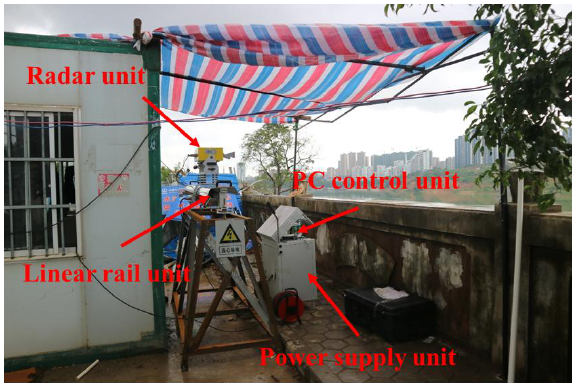
Figure 3. View of the IBIS-L system